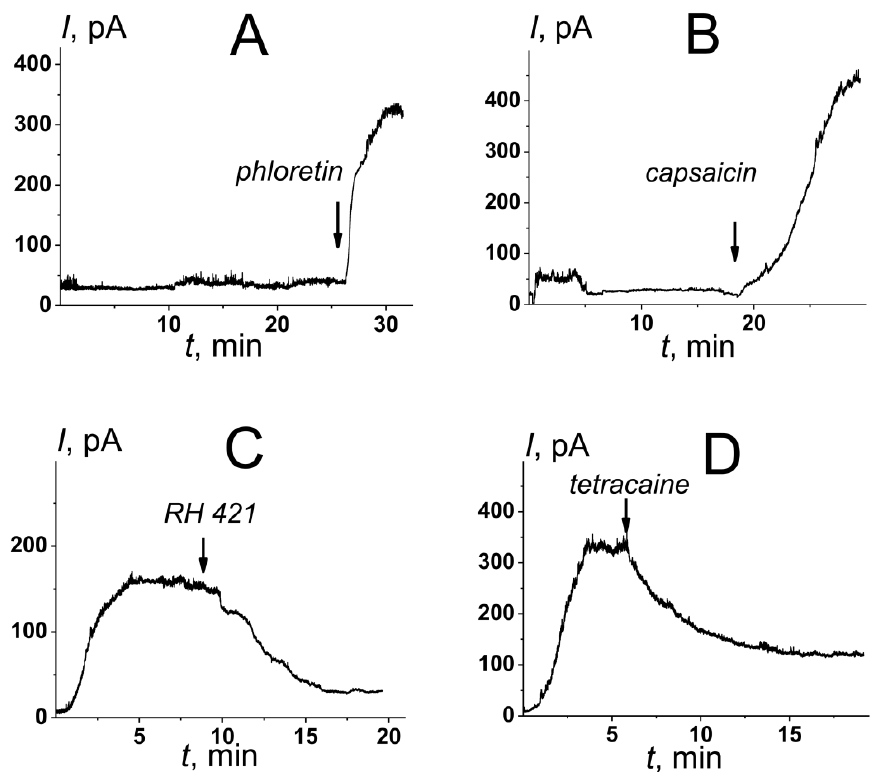
Figure 3. The effects of small molecules altering the membrane boundary potential on the steady-state bilayer conductance induced by cis -side addition of nisin. The moments of introduction of 20 µ M phloretin ( A ), 400 µ M capsaicin ( B ), 5 µ M RH 421 ( C ), and 500 µ M tetracaine ( D ) to the bilayer bathing solution are indicated by the arrows. The membranes were made from DOPC/TOCL (50/50 mol%) and bathed in 0.1 M KCl, pH 7.4. V = 100